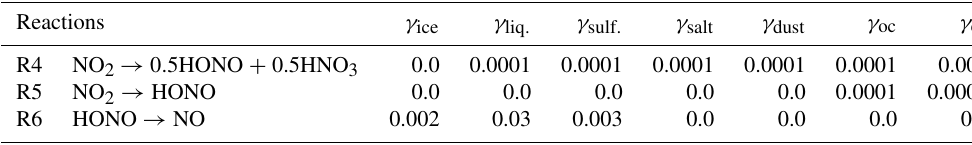
Table 3. Sensitivity simulations in this work. No. Simulation ID HRs (HONO) GRs (HONO) EM (HONO) clouds aerosols 1 OLD